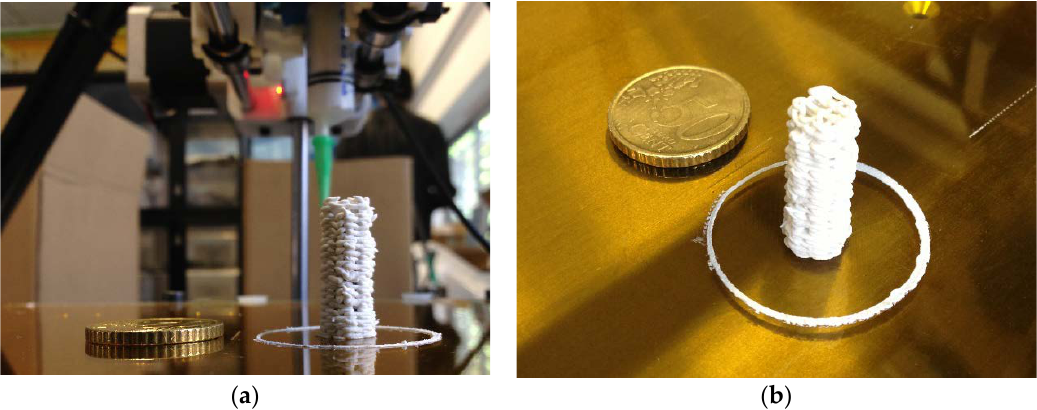
Figure 1. Ceramic ink column constructed adding 40 circular horizontal layers of extruded material with a Robocasting syringe 3D printer (Fundació Privada Centre CIM, Barcelona, Spain) at Centre CIM: ( a ) Elevation view; ( b ) Isometric view.